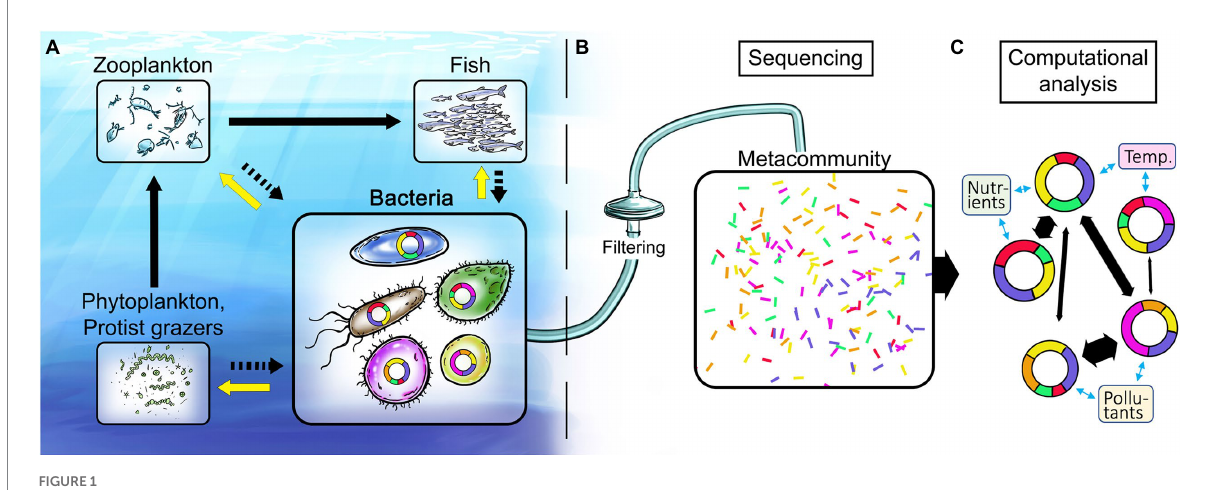
FIGURE 1 Illustration of the marine food web and proposed analysis workflow for disentangling linkages between environmental stressors and genomic structure and content of key marine bacteria. (A) Bacteria are fundamental in recycling of nutrients including dissolved organic carbon (black arrows to bacteria) and in providing ecosystem-wide services to higher trophic levels (yellow arrows). (B) Current state of the art methodology is based on sampling of the total nucleic acid (DNA and/or RNA) content of marine environments. (C) Computational analyses provide metagenome-assembled genomes (MAGs) that give unprecedented insights into both the identity of key bacterial populations and the genes underlying their different functional traits. Doughnut shapes represent genomes of such key bacterial populations and the colored doughnut sections denote traits. Co-occurrence network analysis of bacterial populations and their traits (black arrows between genomes) allows for identification of traits responsive to global change variables (blue arrows) and ultimately the ecosystem services supplied by key